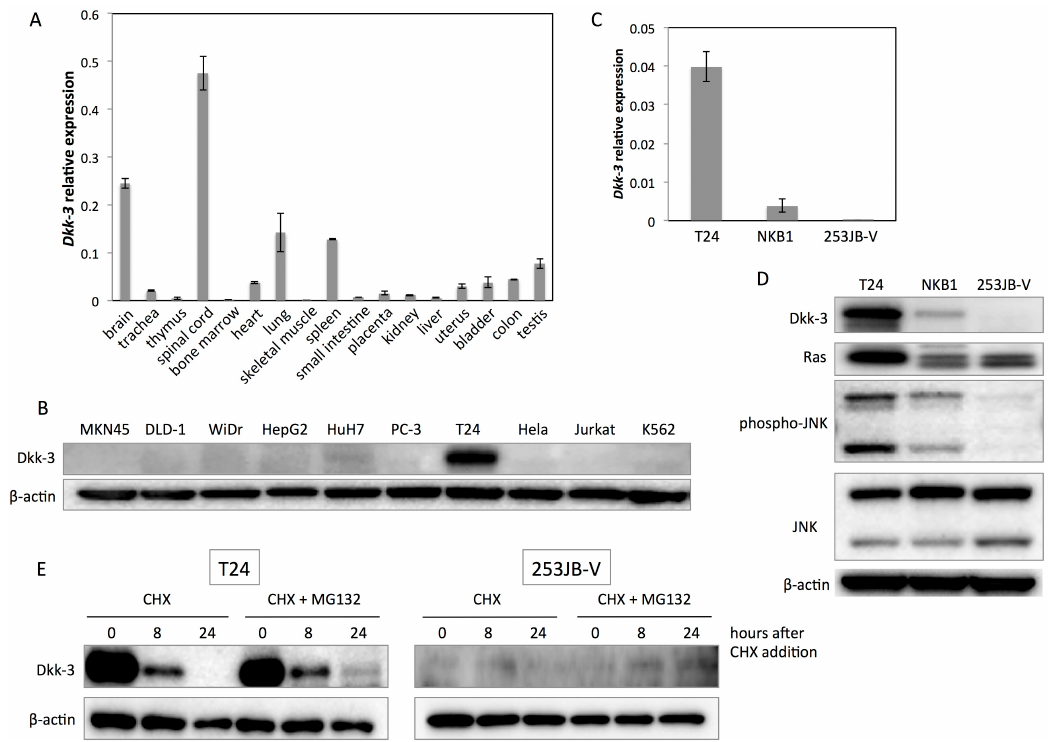
Figure 1. Specific overexpression of Dkk-3 in T24 cells. ( A ) Relative expression levels of Dkk-3 mRNA in various human normal tissues. The expression levels of Dkk-3 mRNA were normalized by those of GAPDH mRNA; ( B ) Dkk-3 protein expressions in various human cancer cell lines; ( C ) Relative expression levels of Dkk-3 mRNA in human bladder cancer cell lines, T24, NKB1 and 253J-BV; ( D ) Protein expression profiles of the bladder cancer cell lines; ( E ) The stability of Dkk-3 protein in T24 and 253JB-V cells determined by treatment with 300 μ g/mL cycloheximide (CHX) in the presence and absence of MG132 (5 μ M). DMSO (5 μ M) was used as negative control reagent for MG132.